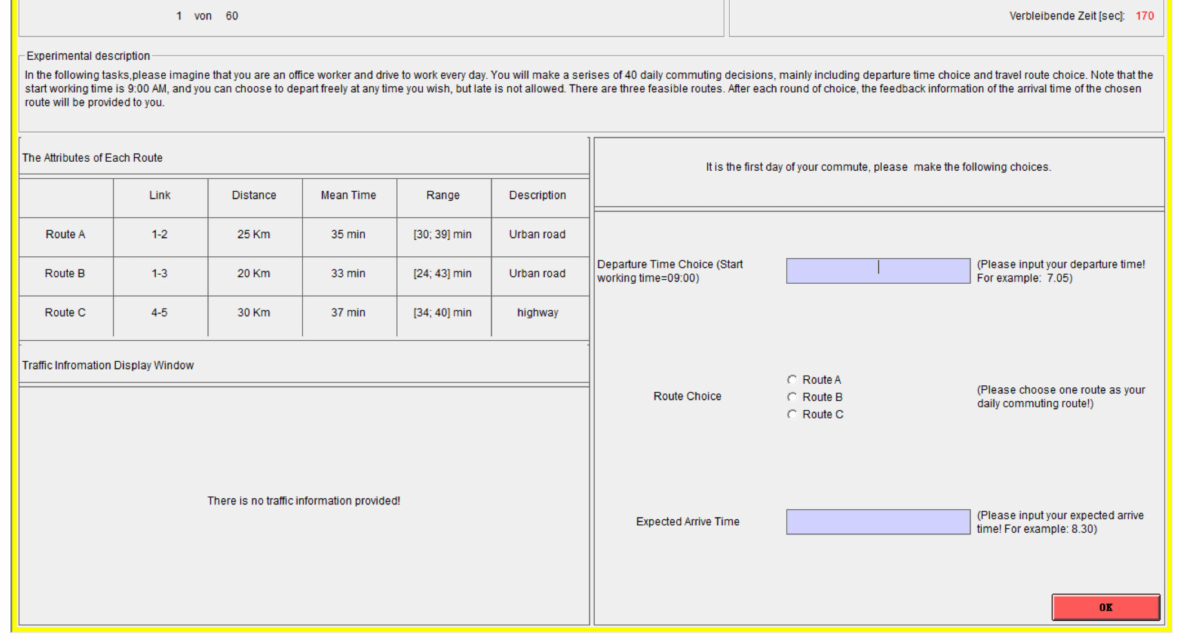
Figure 4. Snapshot of the simulation window (translated from